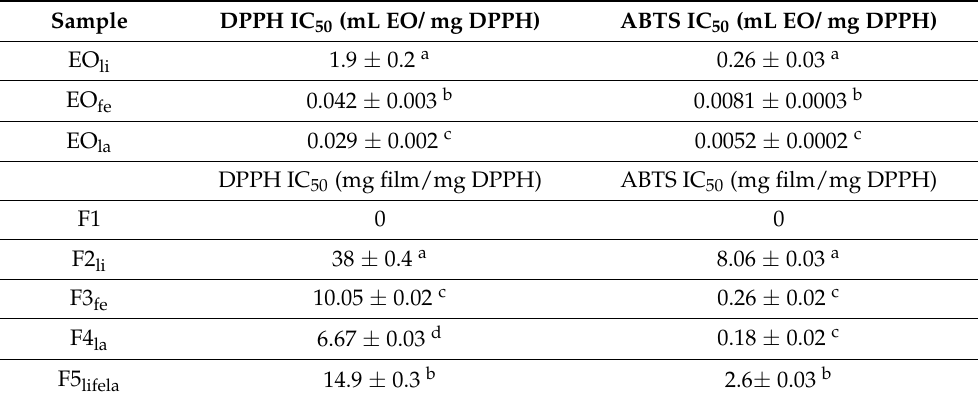
Table 5. Mean values and standard deviation of DPPH IC 50 and ABTS IC 50 of the films and, lime (li), fennel (fe), and lavender (la) essential